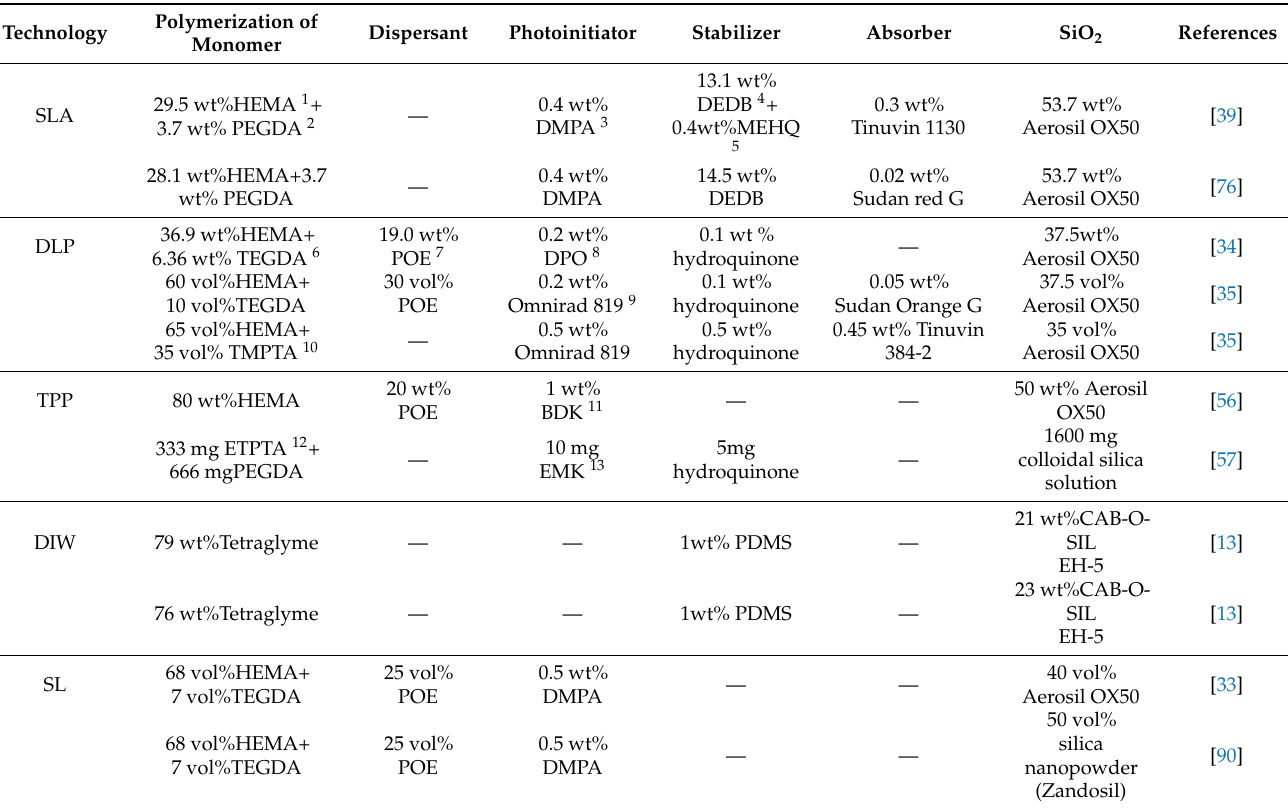
Table 2. Some possible technologies and materials for 3D printing